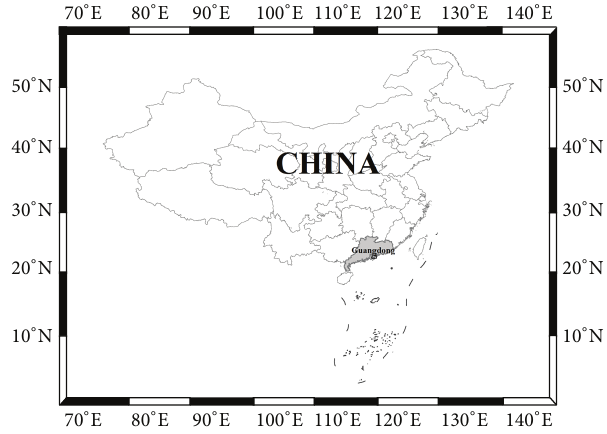
Figure 1: Geographic location of Guangdong in